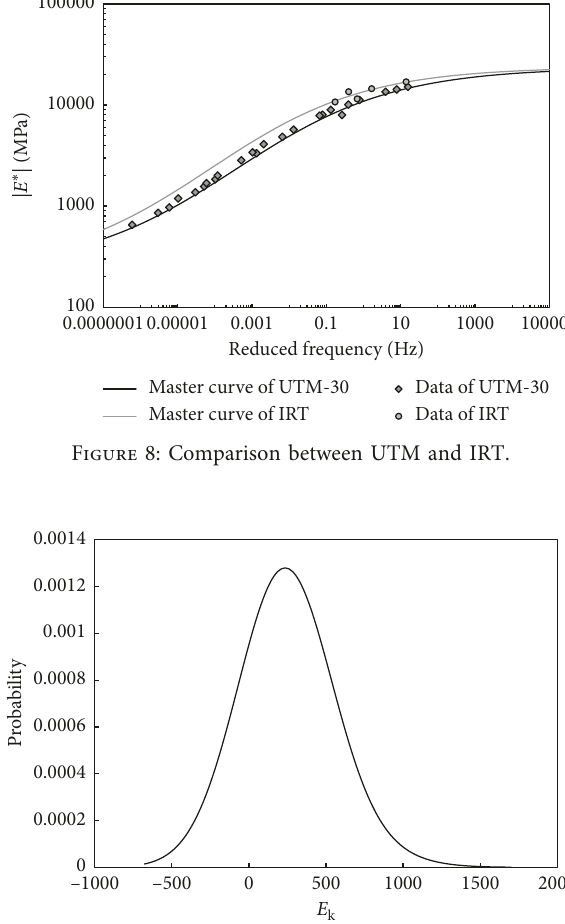
Figure 9: Standard normal distribution of the dynamic modulus of UTM and IRT.